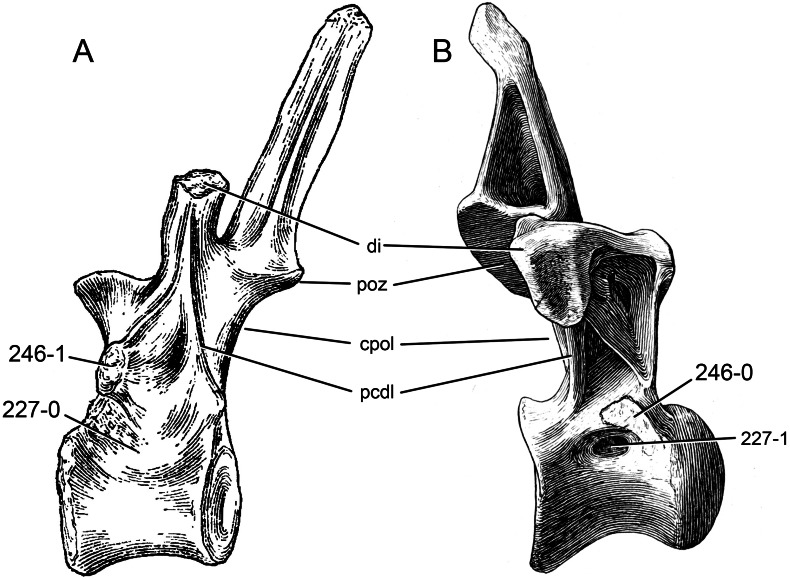
Dorsal vertebra 3 of eusauropods.Dorsal vertebra 3 of Shunosaurus lii ZDM T5401 (A; modified from Zhang, 1988), and Brontosaurus parvus UW 15556 (B; modified from Gilmore, 1936) in left (A) and right (B) lateral view. Note the slightly concave lateral surface of the centrum in Shunosaurus (A; C227-0), in contrast to the well-defined pneumatopore in UW 15556 (B; C227-1), and the different locations of the parapophyses (C246). Abb.: cpol, centropostzygapophyseal lamina; di, diapophysis; pcdl, posterior centrodiapophyseal lamina; poz, postzygapophysis. Scaled to the same total vertebral height.